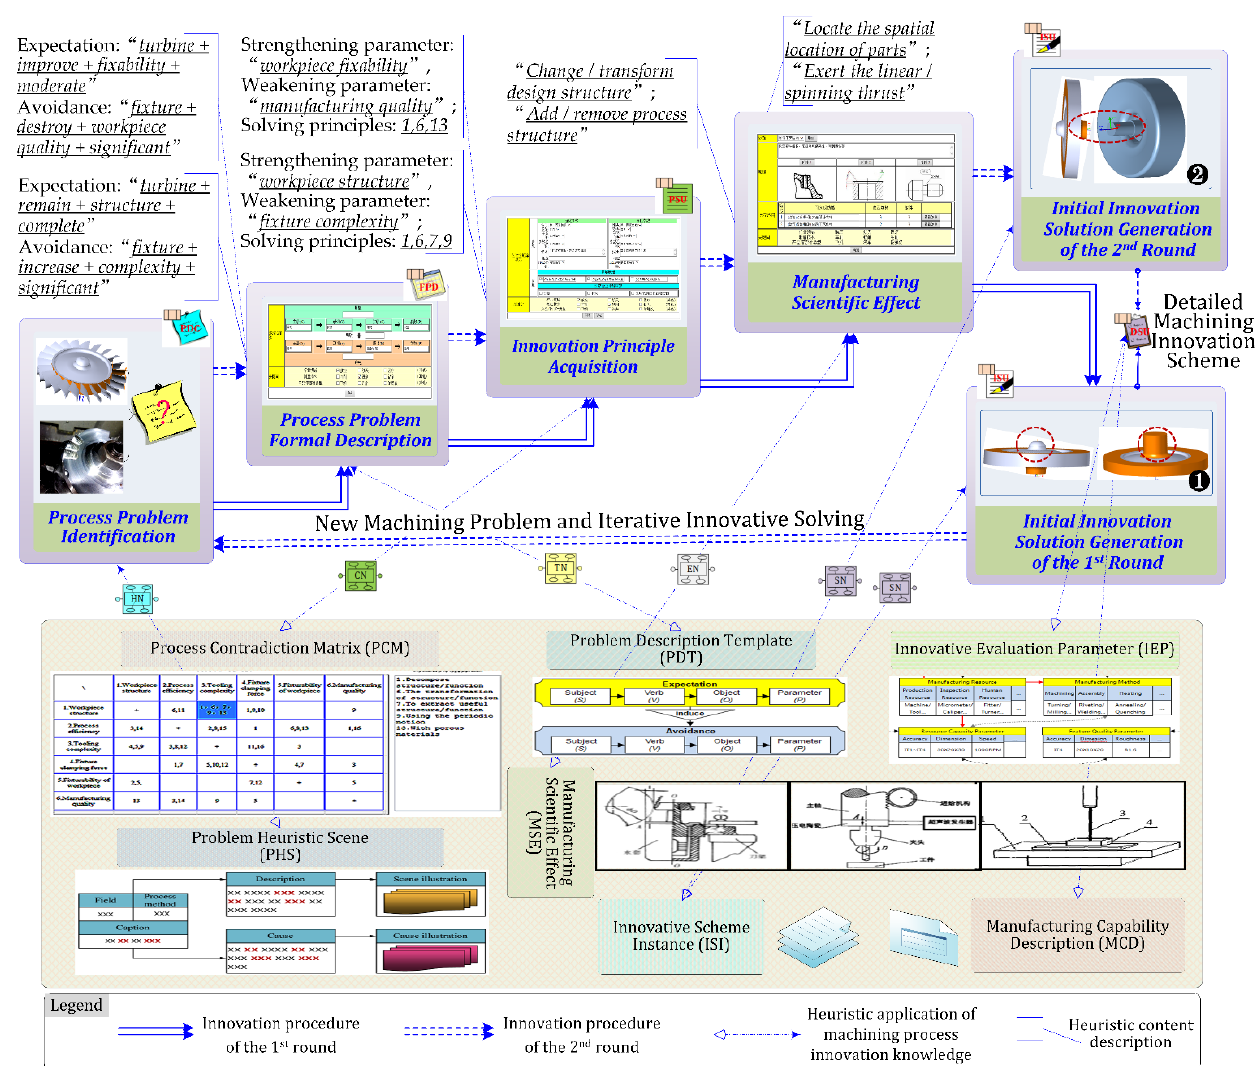
Figure 8. Knowledge-driven heuristic innovation scheme design for micro-turbine machining.